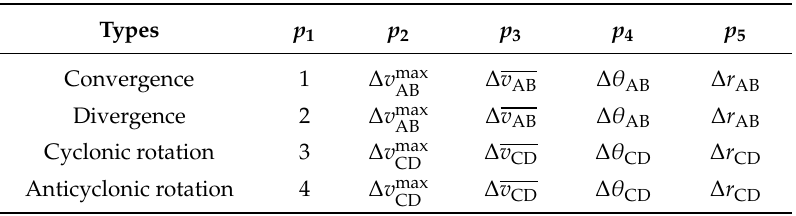
Table 3. Properties of the airflow field.